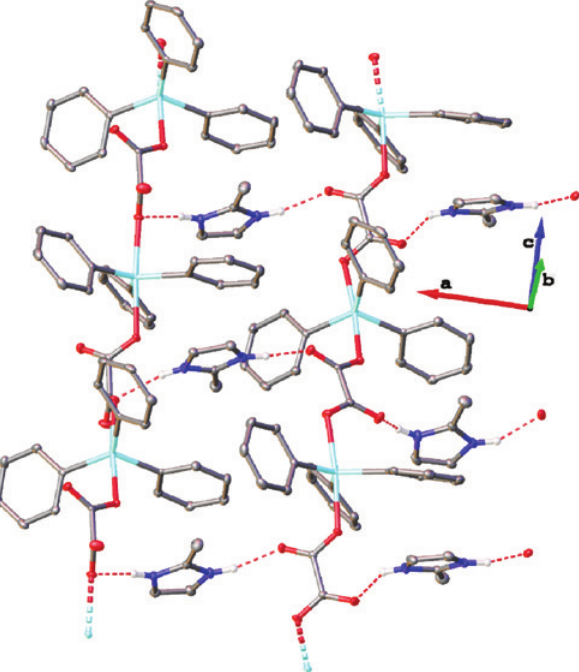
Figure 2: Olex2 view showing the infinite chains of 1 . For clarity, only H atoms involved in hydrogen bonds are depicted. The origin of the coordinate system is arbitrary. Red and dotted line: hydrogen bonds; bicolored stipple cone: covalent bonds.